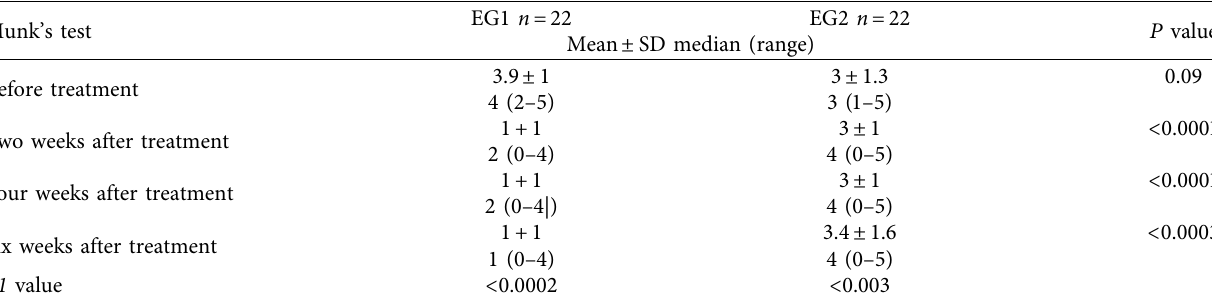
Table 3: Munk’s test results of both groups during follow-up period of six